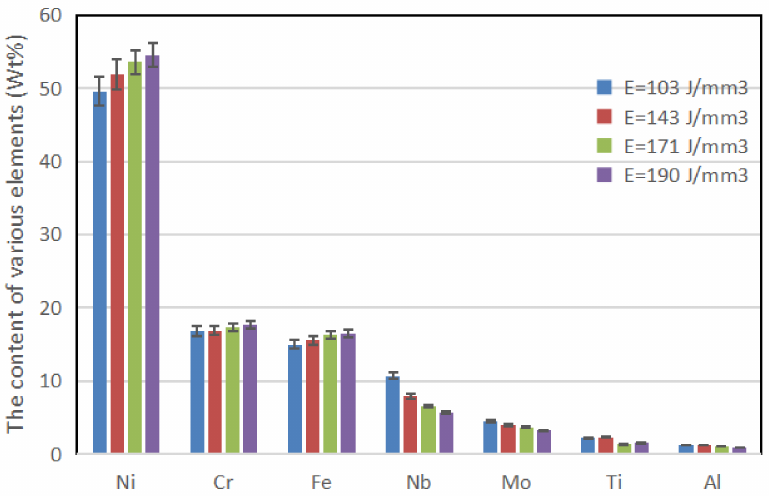
Figure 11. EDS analysis showing chemical compositions at the core of columnar dendrites under different